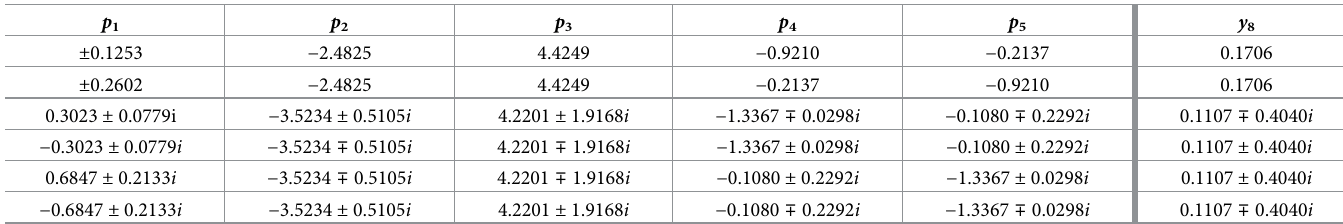
Table 5. 12 possible values of parameters of system F 7 from model